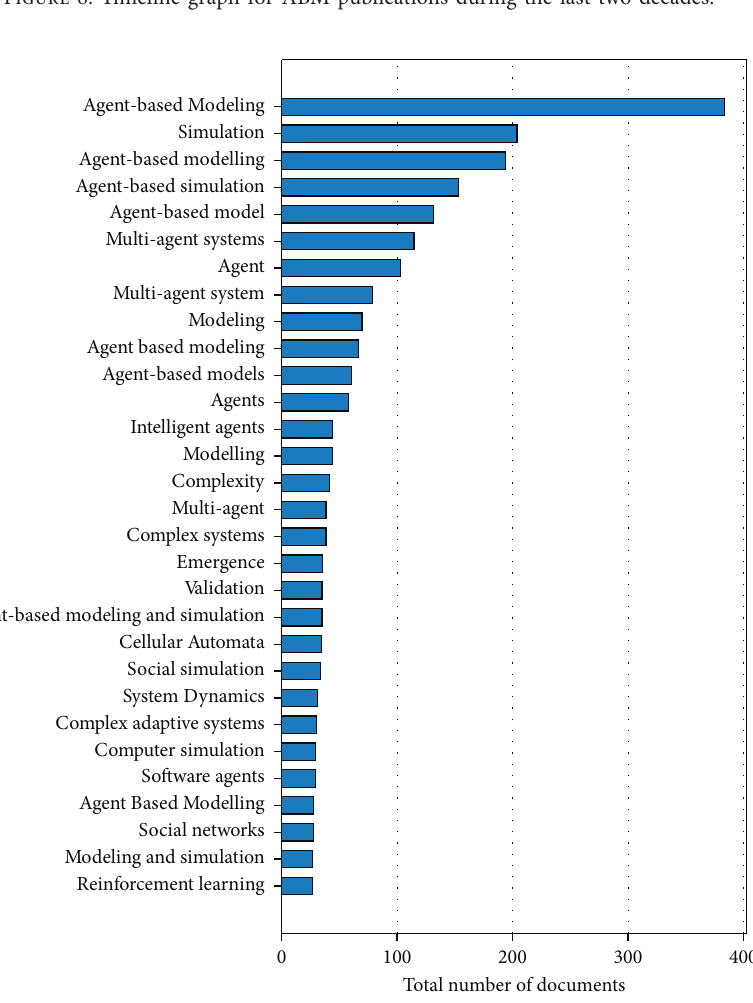
Figure 8: Timeline graph for ABM publications during the last two